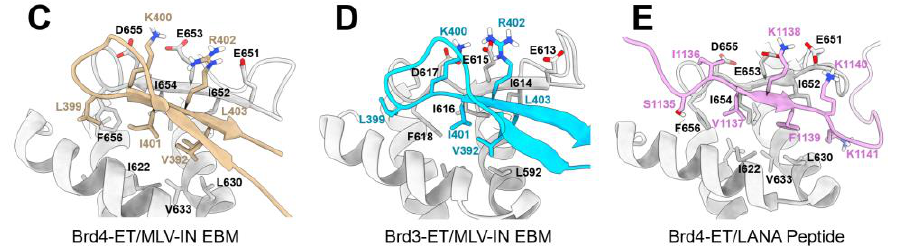
Figure 11. The scheme of the Brd3- or Brd4-ET domain interacting with murine leukemia virus (MLV) integrase (IN) ET-binding motif (MLV-IN EBM) (peach and cyan), LANA (pink), CHD4 (dark blue), and BRG1 (green) peptides. Interacting residues on ET are indicated in black, and interacting residues on corresponding peptides are colored as indicated. ET domains are rotated to present the best angle to see the interacting residues. The PDB codes of associated structures are ( A ) 6BGG, ( B ) 6BGH, ( C ) 2N3K, ( D ) 2ND0, and ( E ) 7JYZ.